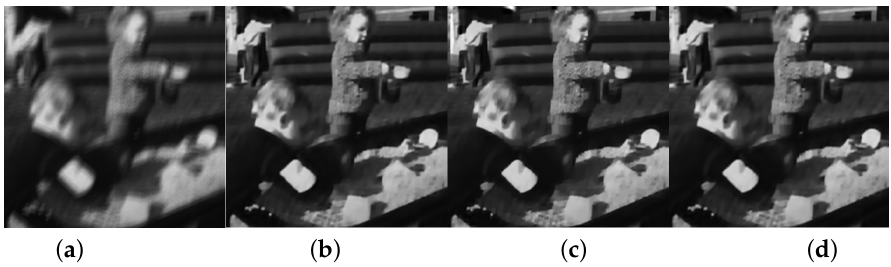
Figure 4. A comparison of our method with state-of-the-art methods. The images ( a – d ) are blurry input, result of Pan et al. [18], result of Yan et al. [19] and our result, respectively. The PSNR values of ( b – d ) are 30.19, 30.33 and 32.15,